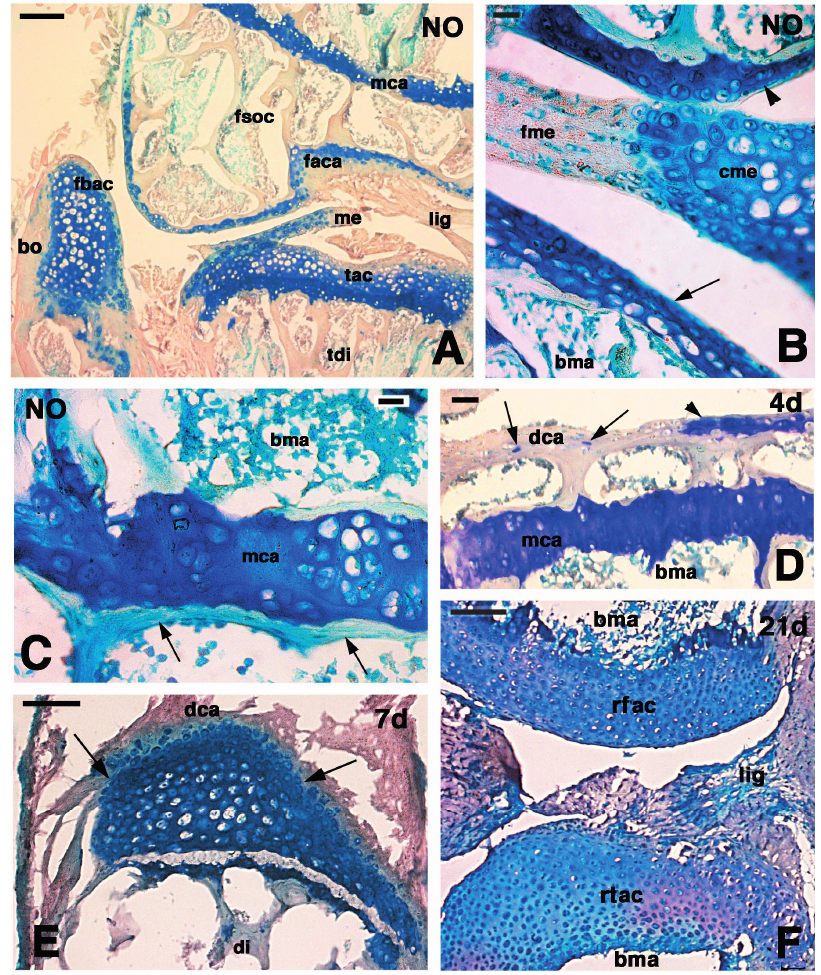
Figure 1. Histology of the main stages of cartilage regeneration in the knee. ( A ) detail on the epiphyses of the three long bones of the normal knee (NO) showing the extensive basophilic areas forming the articular cartilages. Bar, 50 µm; ( B ) detail on the normal articular cartilage (NO) of the femur (arrowhead) and of the tibia (arrow) with interposed the fibrous and cartilage regions of the meniscus. Bar, 10 µm; ( C ) detail of the metaphyseal growth plate bounded by a continuous bone (arrow) in the diaphyseal side of normal knee (NO). Bar, 10 µm; ( D ) loss of the basophilia in the articular cartilage of the femur four days post-injury. Only small cells (arrows) or basophilic areas (arrowhead) remain in the articular cartilage but are still extensive in the metaphyseal growth plate. Bar, 25 µm; ( E ) Nucleus of regenerating cartilage (arrows) located underneath the degenerated surface of the articular cartilage in a tibia seven days post-injury. Bar, 50 µm; ( F ) complete regenerated femur and tibia epiphyses 21 days post-injury. Note the dense cellular density of the chondrocytes. Bar, 50 µm. Legends: bo, bone; bma, bone marrow; cme, cartilage of the meniscus (lunula); di, diaphyseal bone; dca, degenerated cartilage; faca, articular cartilage of the femur; fbac, articular cartilage of the fibula; fme, fibrous connective of the meniscus; fsoc, secondary ossification center of the femur; lig, ligament; mca, metaphyseal cartilage; me, meniscus; rfac, regenerated femur articular cartilage; rtac, regenerated tibia articular cartilage; tac, articular cartilage of the tibia; tdi, tibia diaphyseal